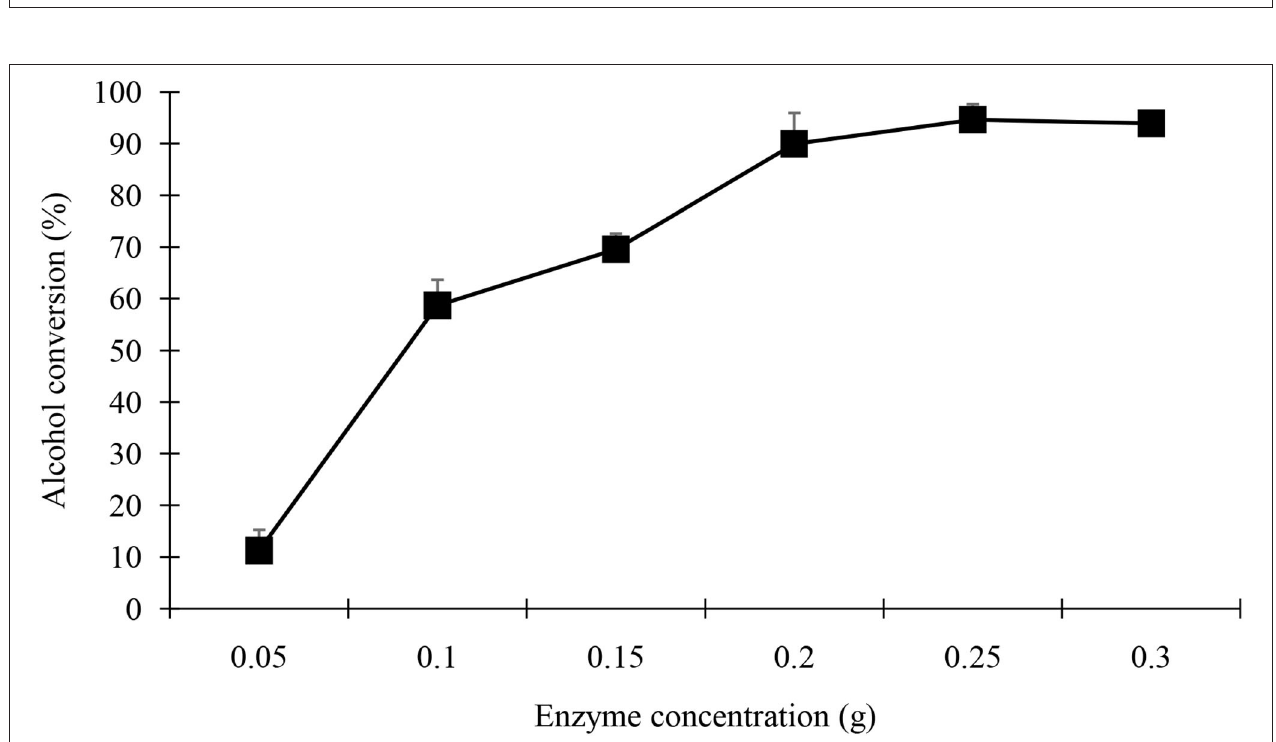
FIGURE 10 | Effect of enzyme amount on the percent yield of geranyl butyrate ester. The reaction mixture consists of 0.25M of butyric acid and 0.25M of geraniol at 37 o C in 5ml of hexane containing different amount of black cumin seedling acetone powder for 48h.